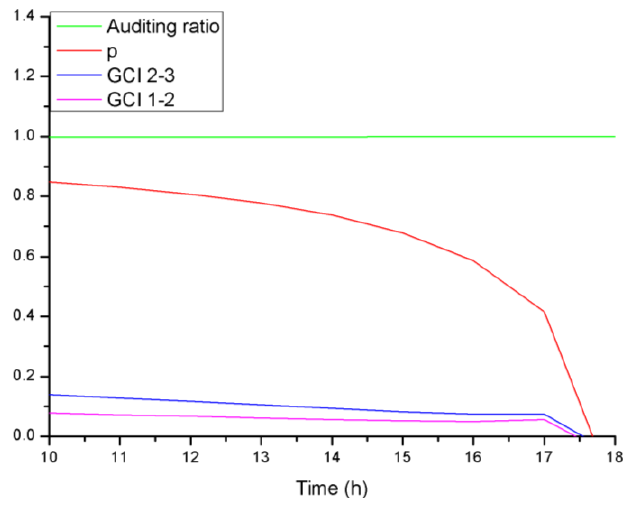
Figure 11. Grid convergence indexes, auditing ratio and order of convergence vs. time (time step